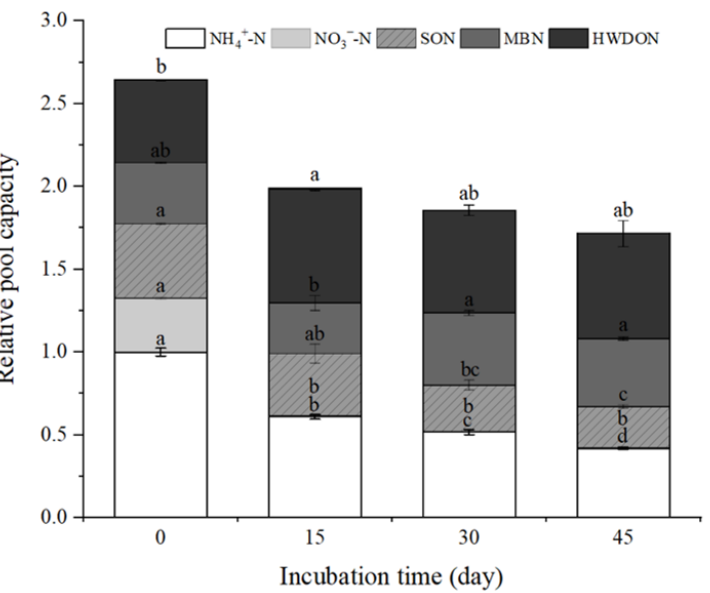
Figure 2. Relative pool capacity of the available nitrogen fractions in the compost. Assuming that the capacity of the NH 4+ -N pool at day 0 was 1, the capacities of the remaining measured N were obtained by dividing their contents by the content of NH 4+ -N at day 0. SON, MBN, and HWDON indicate soil organic nitrogen, microbial biomass nitrogen, and hot-water extractable organic N, respectively. Different letters indicate significant differences in a certain N fraction content between different stages ( p < 0.05). Data are shown as the mean ± standard error ( n = 5).